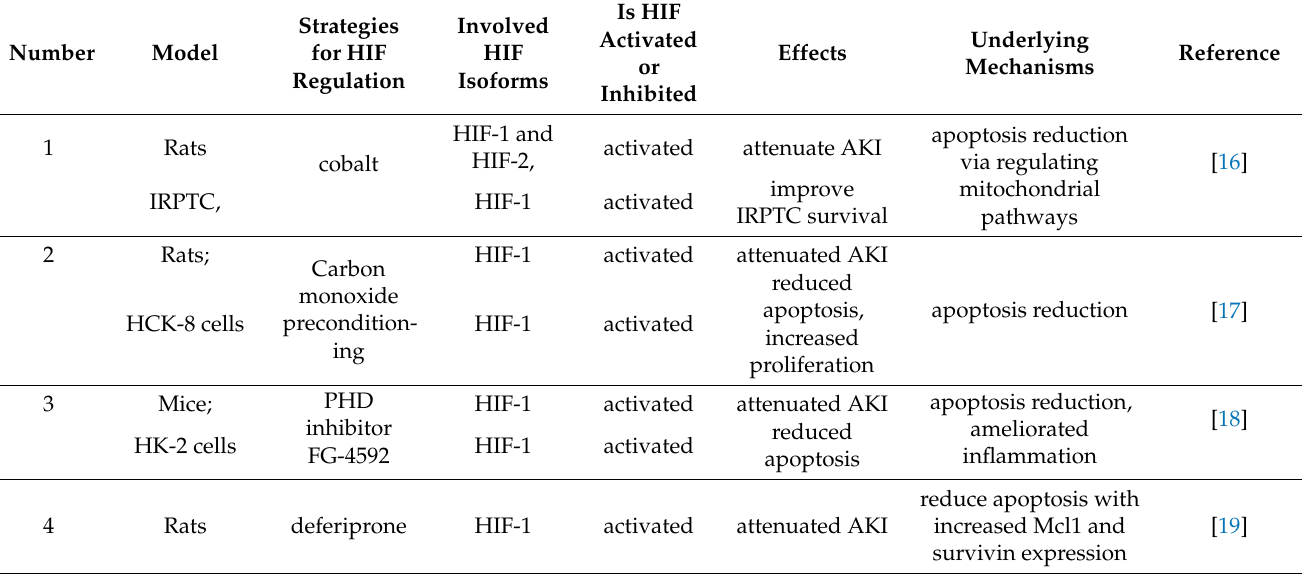
Table 1. Summary of studies about the role of HIF in cisplatin-induced